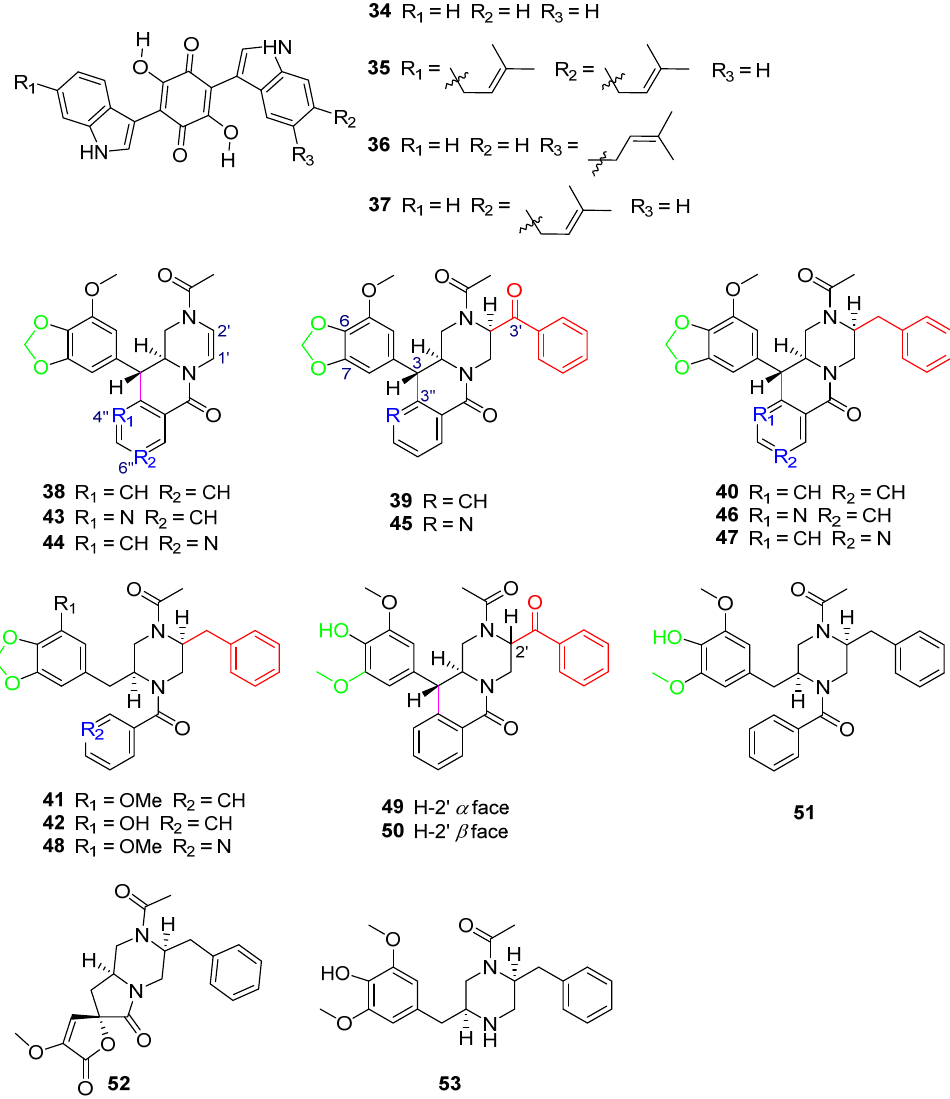
Figure 10. Structure of alkaloids 34 – 53 [19,53,54]. The different color highlighted the different structural characteristics of 38 – 51.